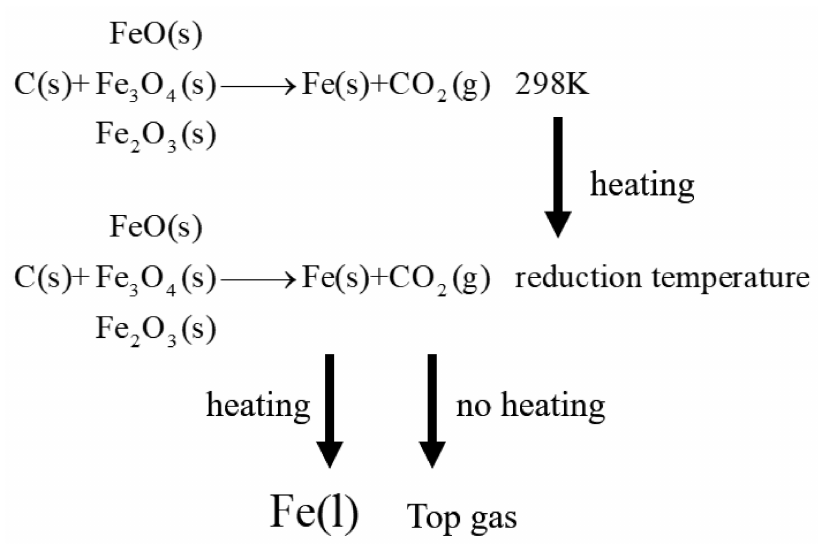
Figure 20. Schematic diagram of the ideal model of ironmaking by carbon.